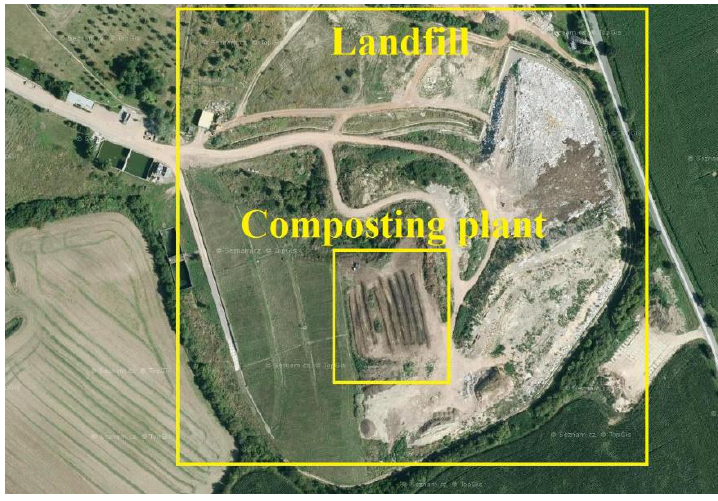
Figure 2. Location of composting plant.